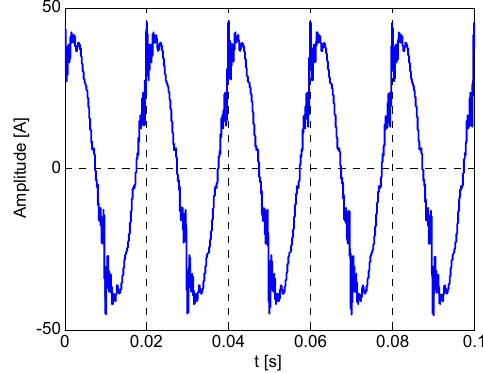
Figure 3. Case study 1: Synthetic current waveform.